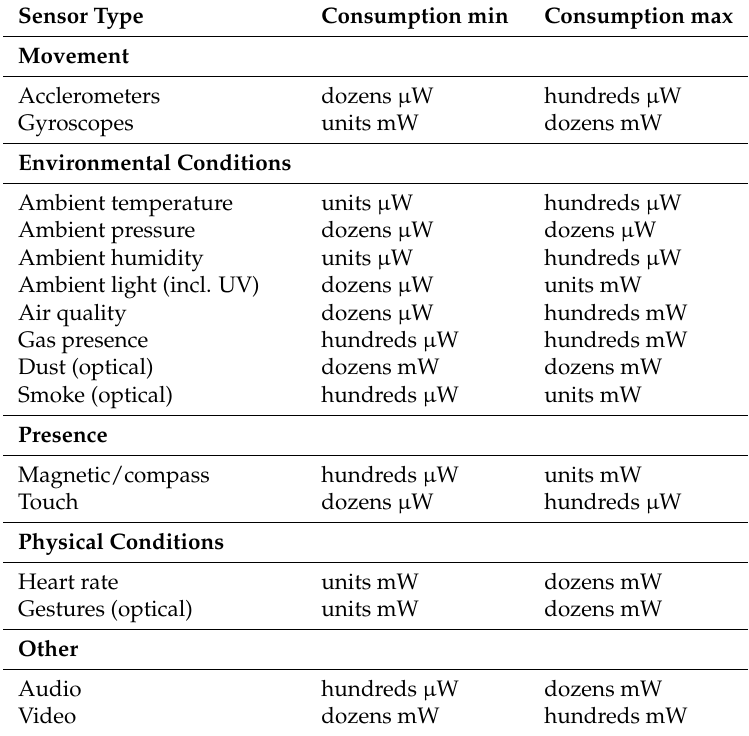
Table 2. Consumption of the state-of-art commercial sensors.